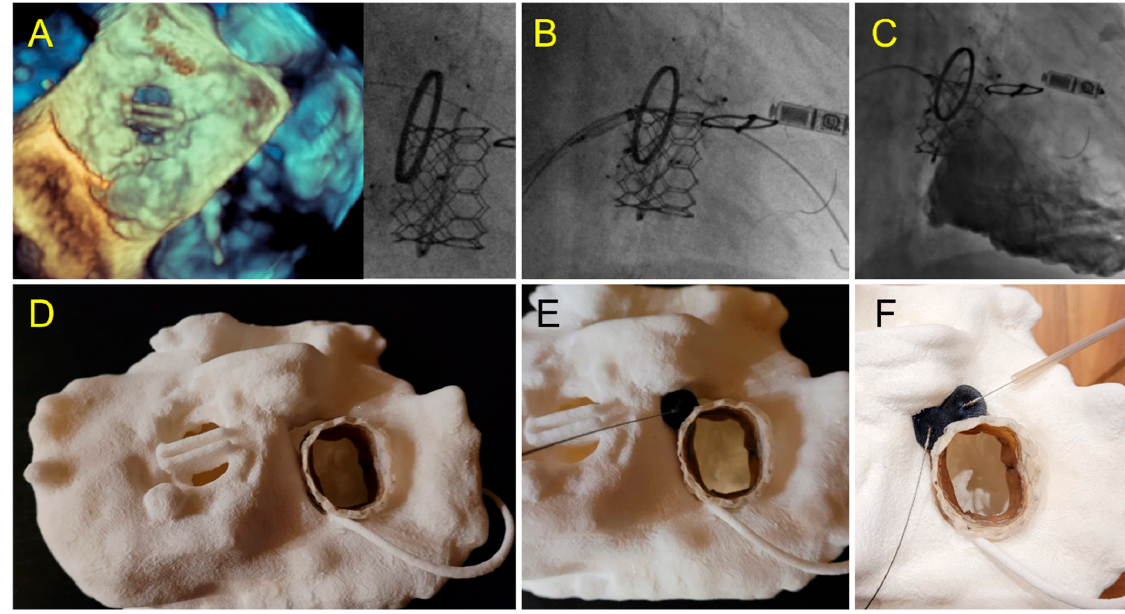
Figure 9. Case 6: Tricuspid PVL. ( A ) Prior Mechanical mitral prosthesis and tricuspid annuloplasty with massive residual tricuspid regurgitation; ( B ) valve-in-ring procedure with Sapien 3 29 mm implanted in the Carpentier Tricuspid ring 36 mm with a septal superior residual gap closed by the insertion of two AVP2 devices.; ( C ) fluoroscopic view of valve-in-ring prosthesis and two AVP2 14 mm devices without residual tricuspid regurgitation during contrast injection; ( D – F ) pre-operative step by step simulation. ( D ) Valve-in-ring implantation. ( E ) A first AVP2 is positioned with residual PVL. Implantation of a second AVP2 with complete closure.